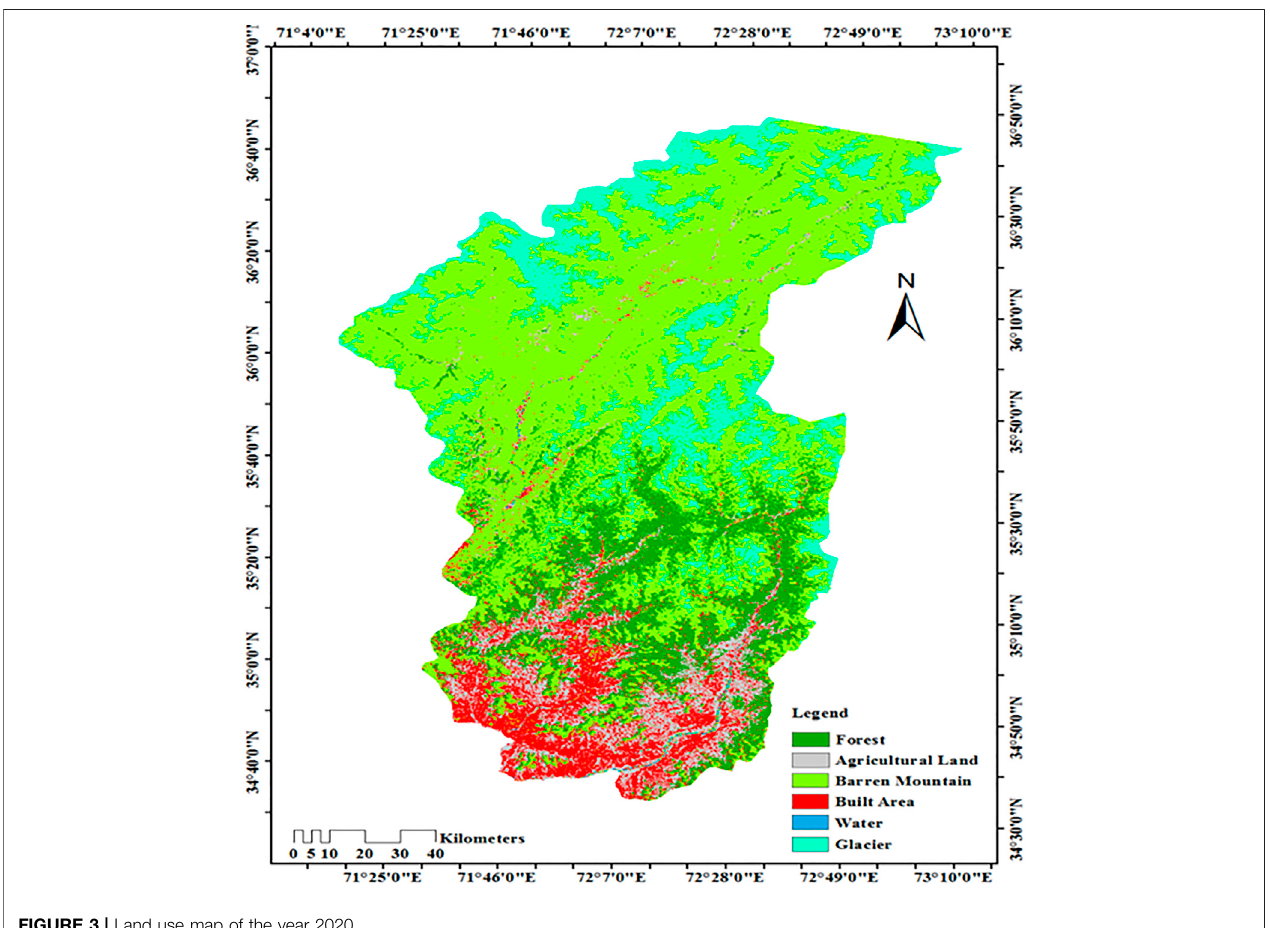
FIGURE 3 | Land use map of the year 2020.